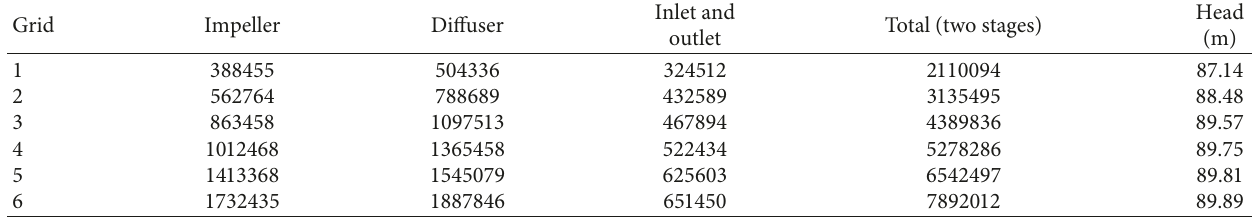
420m 3 /h; n (cid:29) (cid:29)